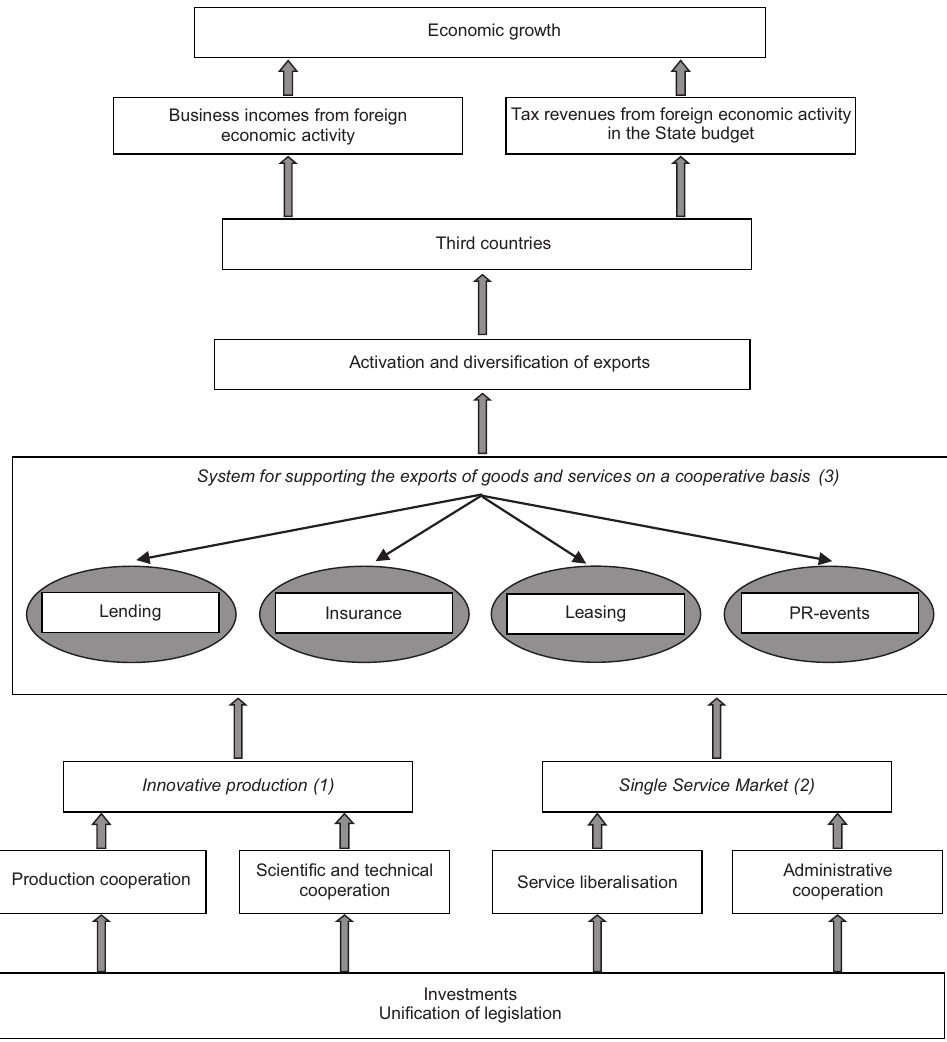
Fig. 3. Development of goods exports and service exports within the EAEU economic cooperation. Source: own